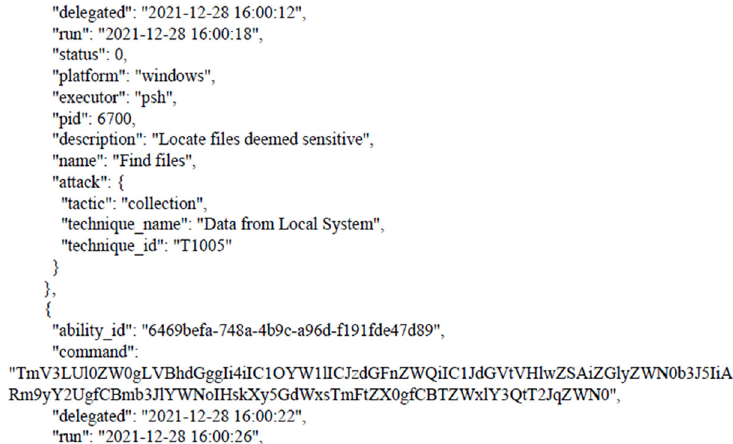
Figure 8. CALDERA commands/report.